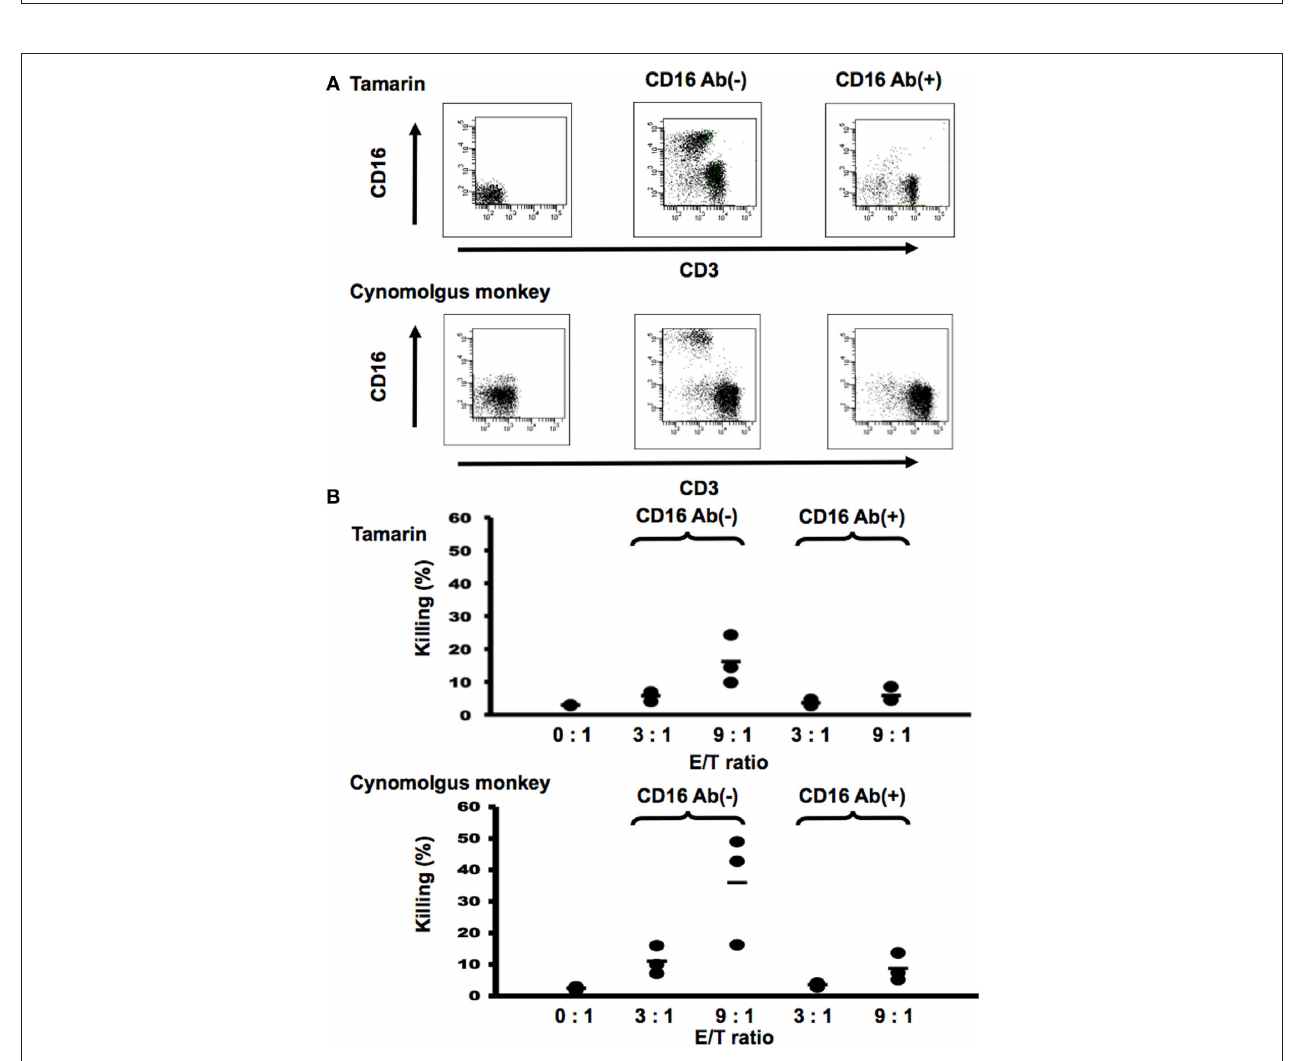
Figure 4 | CD16 + cells were a major population with natural killer activity in tamarins. (A) CD16 + cells were depleted from PBMCs by MACS as described in Section “Materials and Methods”. CD16 − PBMCs were obtained by negative selection using MACS.